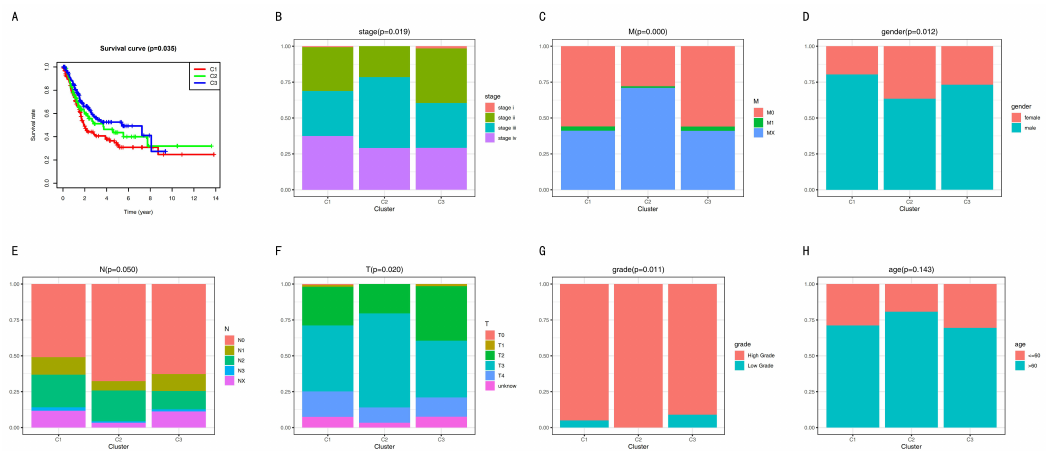
Figure 2. The overall survival (OS) curve and clinicopathologic features. ( A ) Overall survival curve. ( B – H ) Clinicopathologic features among the three subgroups.